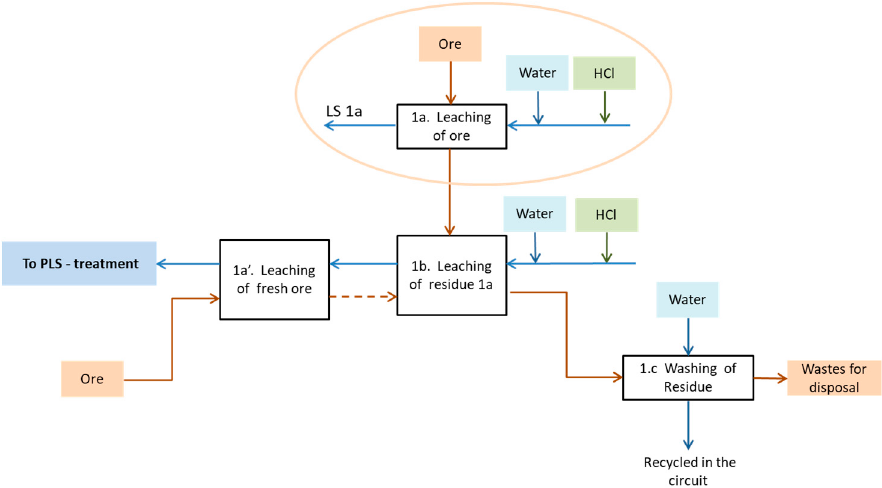
Figure 2. The experimental procedure for the simulation of counter-current leaching (CCL) operation during HCl leaching of the laterite ore.